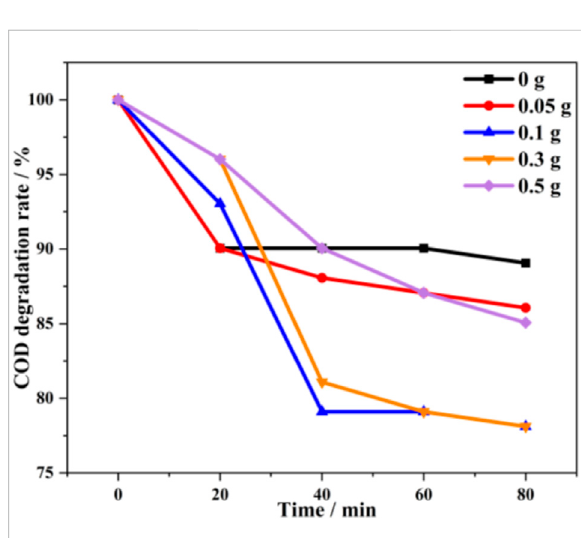
FIGURE 9 Comparison of different α -Ni(OH) 2 dosages for the photocatalytic degradation of hydroxypropyl gel